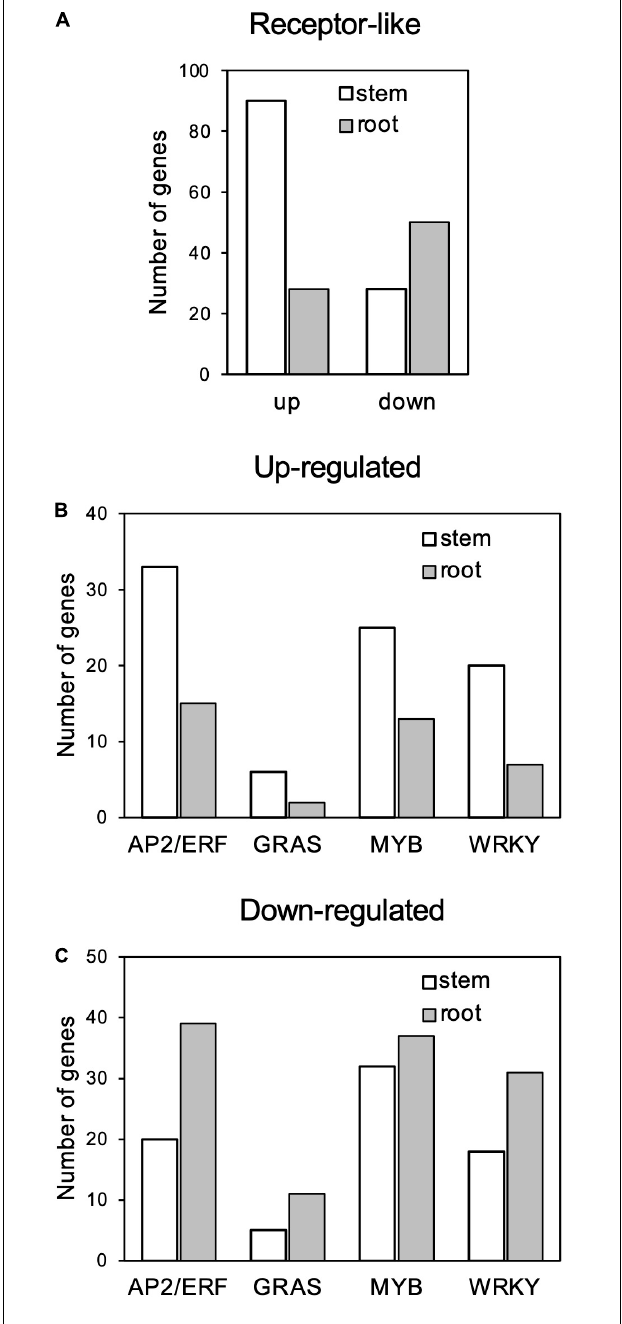
FIGURE 6 | Number genes of receptor-like proteins (A) and AP2/ERF, GRAS, MYB, and WRKY transcription factors (B) up- and (C) downregulated in response to Calonectria ilicicola infection in stems and